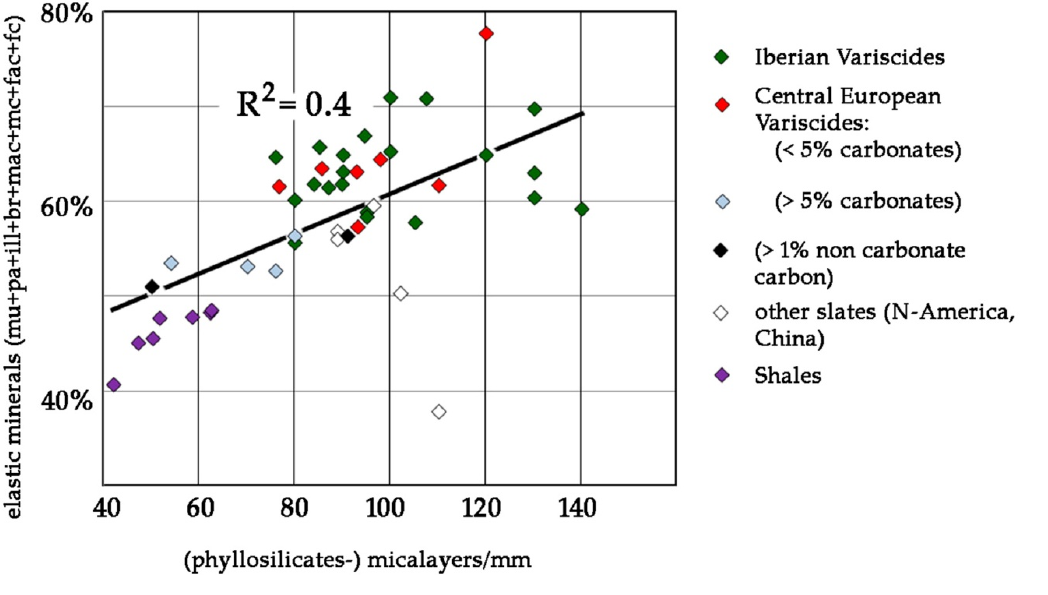
Figure 11. The relationship between calculated “elastic minerals“ (see Table 2 and Section 2.4(i)) (slatecalculation) and the mica-layers per mm in the sense of EN 12326-2 [11].